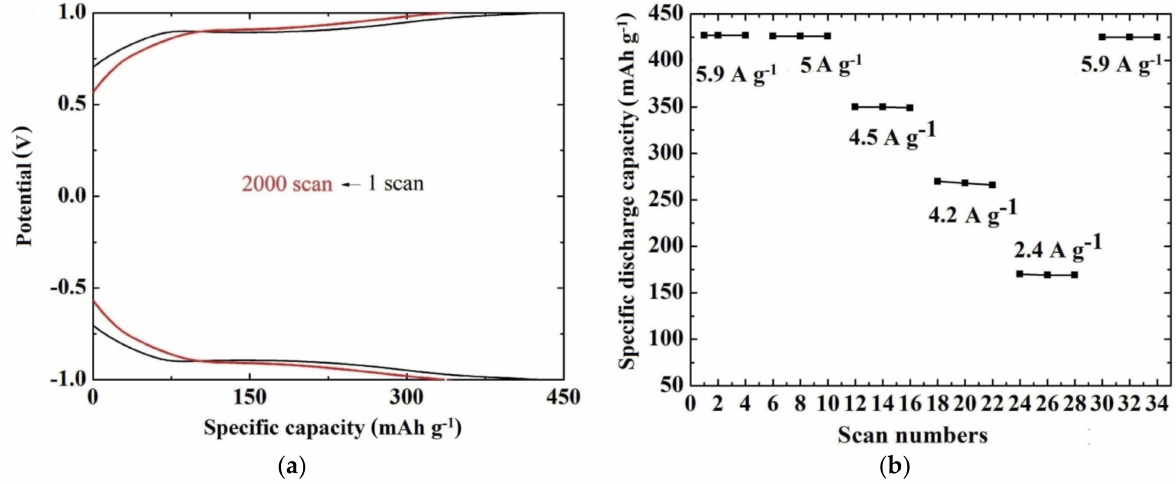
Figure 5. ( a ) Chronopotentiometric curves of the AACVD V 2 O 5 coating (2 cm × 2 cm × 0.3 cm) at 500 ◦ C at a specific current of 5.9 A g − 1 for the 1st and the 2000th scan. ( b ) Rate capability of the same sample at specific current values ranging from 5.9 to 2.4 A g − 1 and then back to 5.9 A g − 1